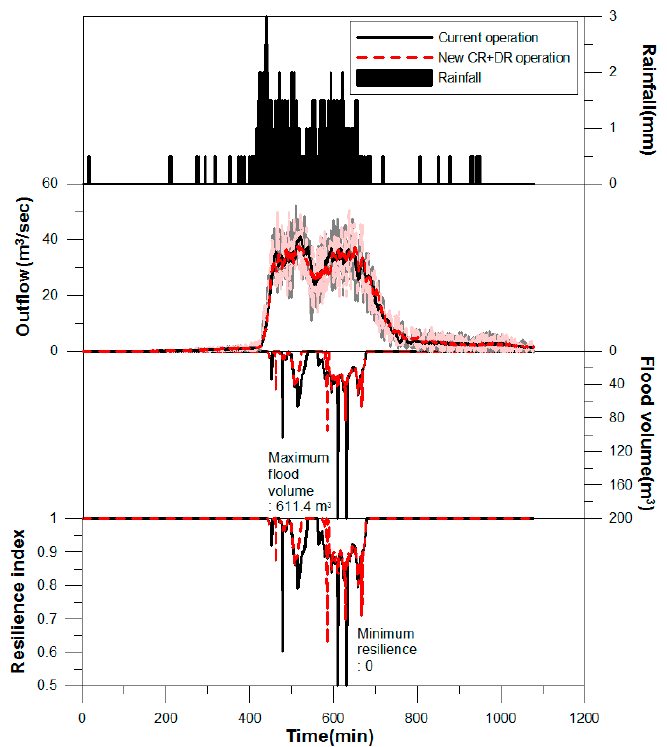
Figure 17. Rainfall, runoff, flood volume and resilience in the target watershed (2010).